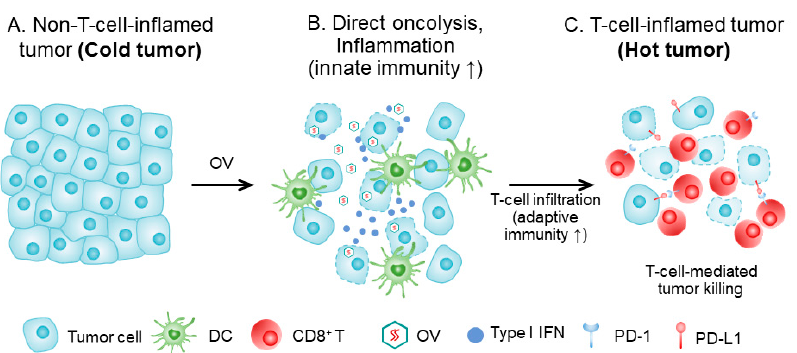
Figure 1. How OV turns a cold tumor hot. ( A ) Tumor tissue prior to OV treatment, with cancer cells (and stromal cells), lacking immune infiltrate (‘cold’ tumor). ( B ) The tumor tissue shortly after